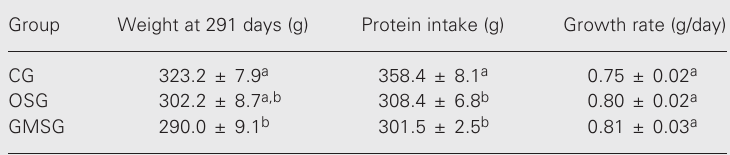
Table 2. Weight, protein intake and growth rate of 291-day-old animals. Group